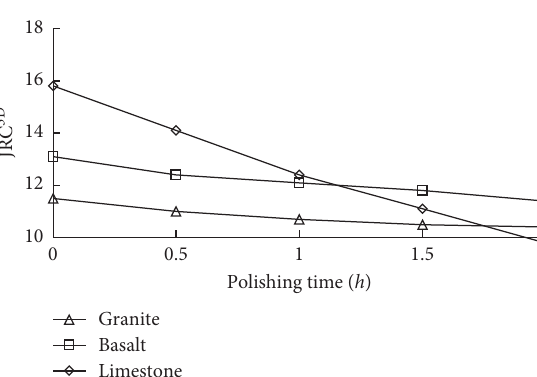
Figure 10: The roughness trend of different aggregate types with increasing polishing time.